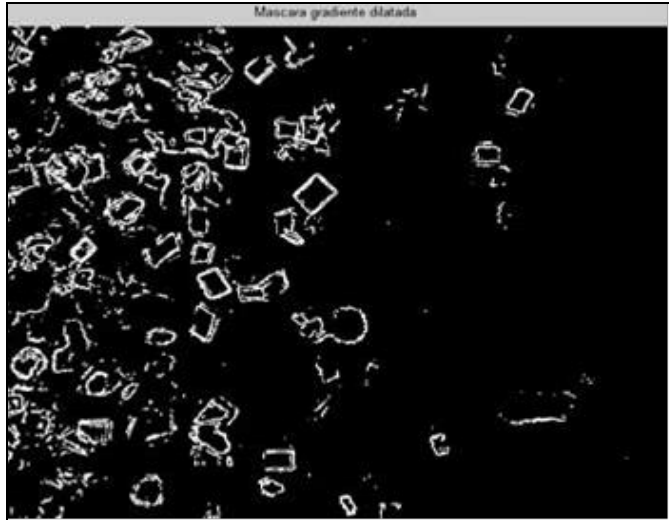
Figura 10: Imagen Dilatada. Fuente: Los autores, (2018).